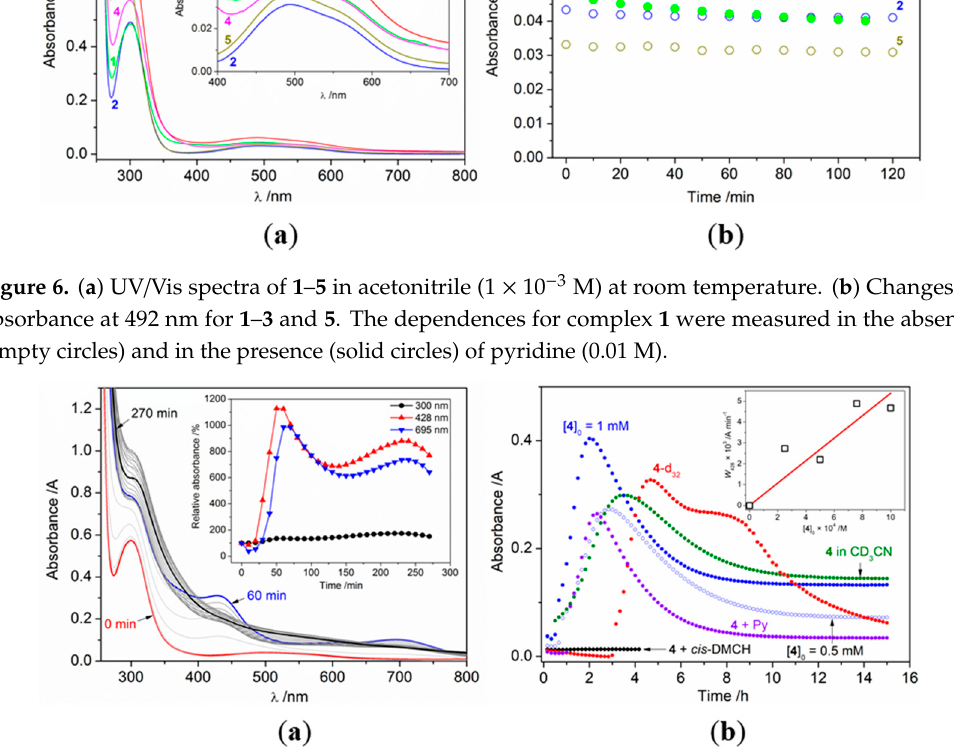
Figure 7. ( a ) UV / Vis spectra of 4 in acetonitrile (1 × 10 − 3 M) in the 4 mL cells along the time. The inset shows changes in the absorbance at 300, 428 and 695 nm with time. ( b ) Absorbance at 428 nm as a function of time for 4 (1 × 10 − 3 M, unless states otherwise) in the 1.5 mL cells in normal CH 3 CN, 4 in CH 3 CN in the presence of pyridine (0.01 M), 4 in CD 3 CN, deuterated 4 -d 32 in CH 3 CN, and 4 in CH 3 CN in the presence of cis -1,2-dimethylcyclohexane. The inset shows the dependence of 428 nm absorbance increase rate ( W 428 ) on [4] 0 .